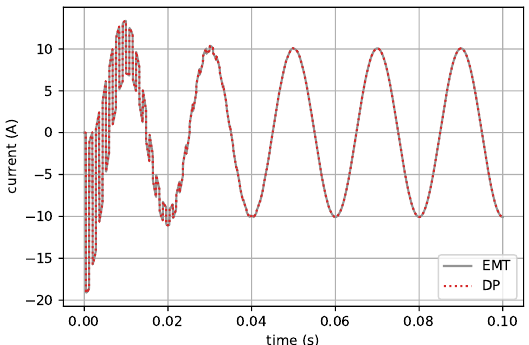
Figure 4. Comparison of DP and electromagnetic-transient (EMT) resistor current results for the transmission line model.